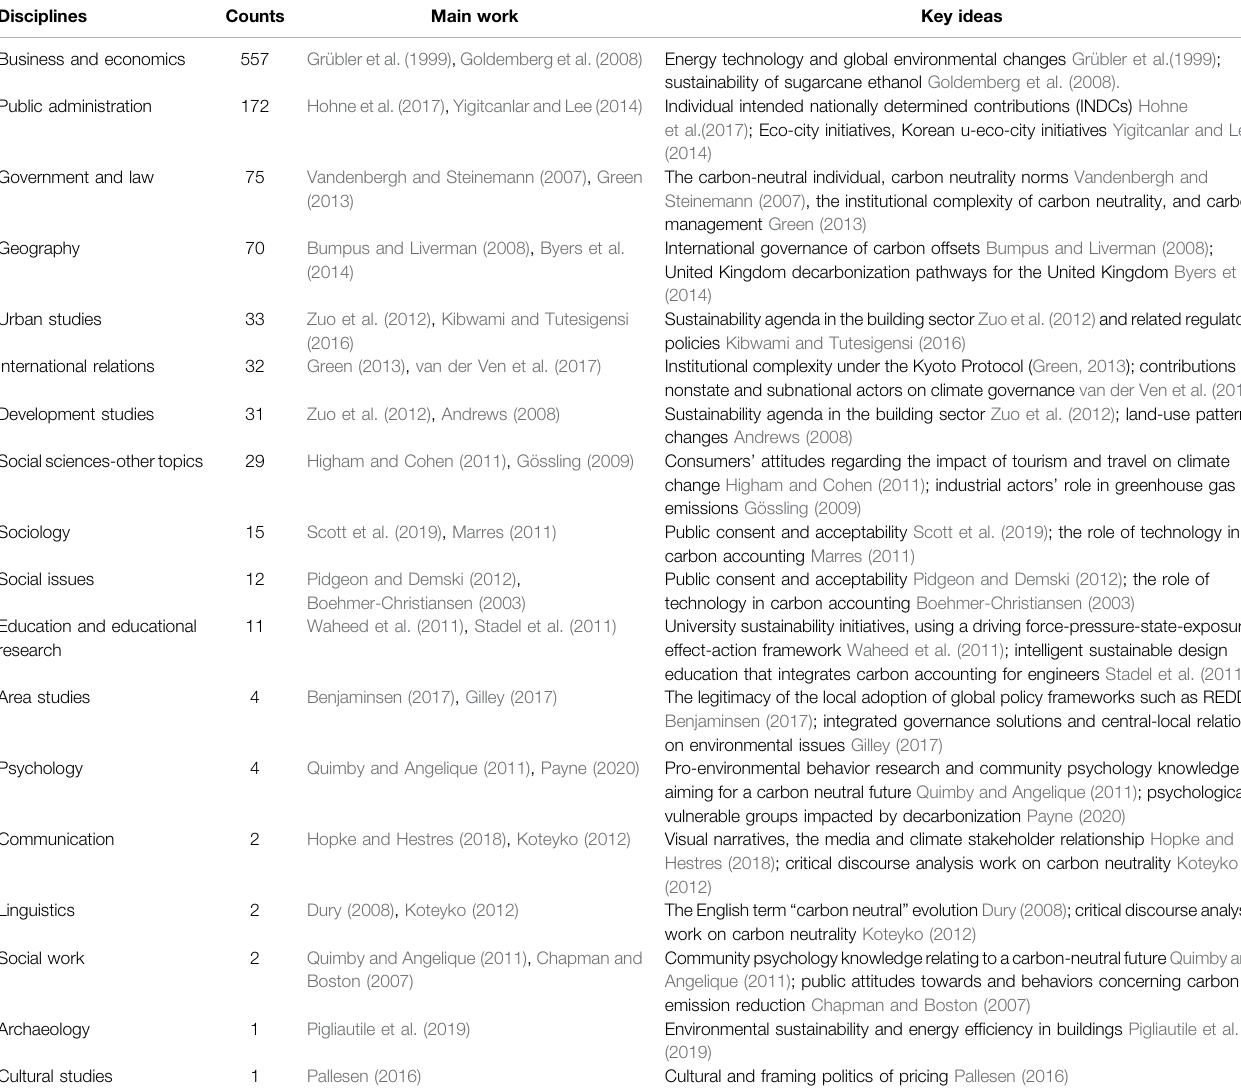
TABLE 7 | Main research: social science